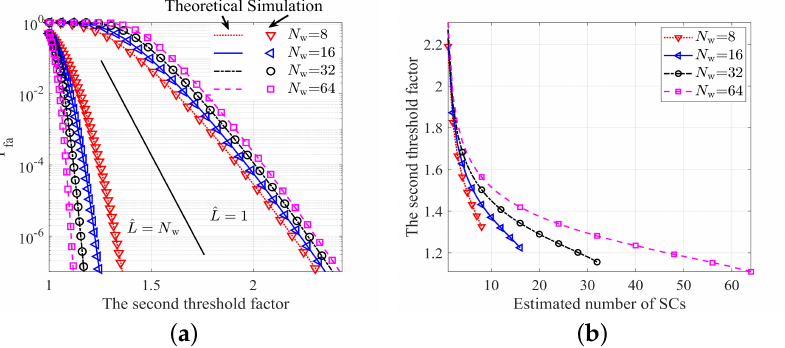
Figure 11. The relationship between the P fa of DT-HGRFT and the second threshold factor. ( a ) The P fa in two special cases ( (cid:98) L = 1, N w ). ( b ) The relationship between threshold factor and estimated number of